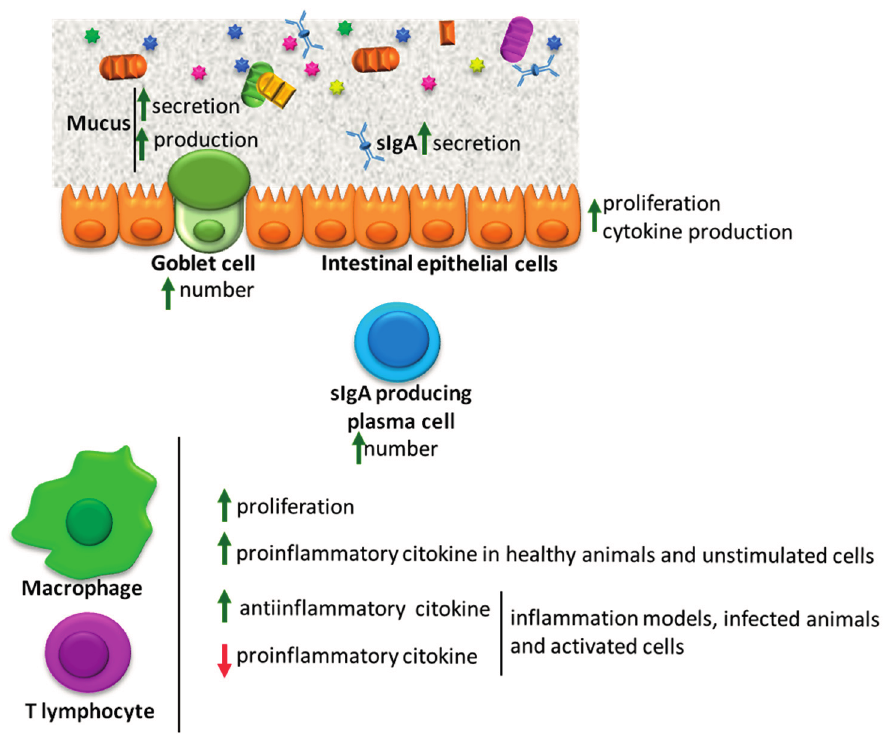
function. ↑ : enhanced; ↓ :